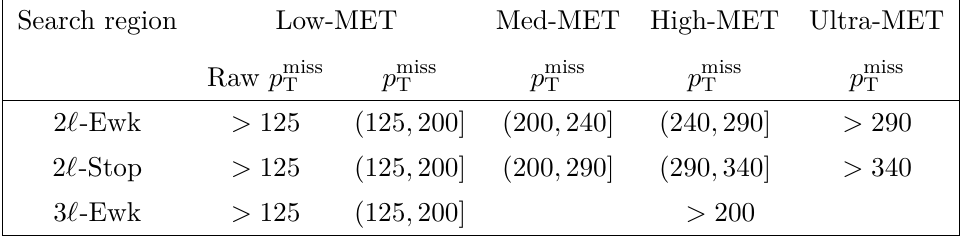
Table 1 . Definition of the MET bins of the SRs. The boundaries of raw p miss of every bin are